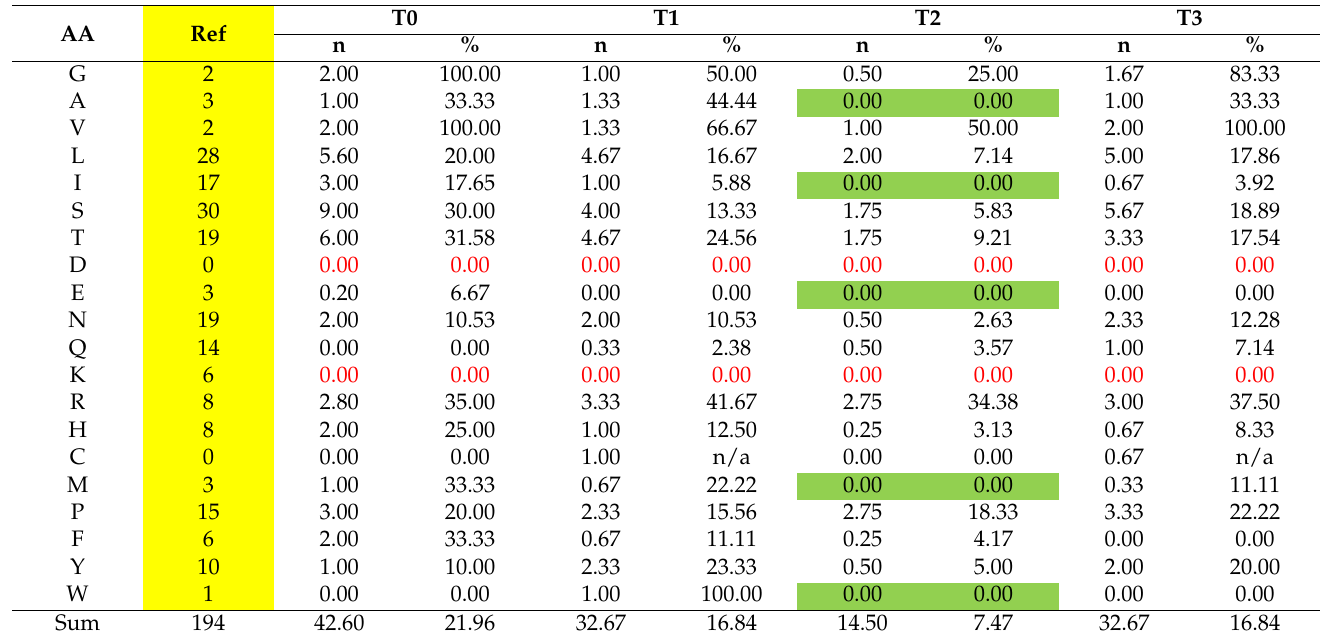
Table 5. The average frequency of mutation of amino acids encoded by nicotinamide adenine dinucleotide hydride (NADH) dehydrogenase 1 (ND1) of mitochondrial deoxyribonucleic acid (mtDNA) in each group.